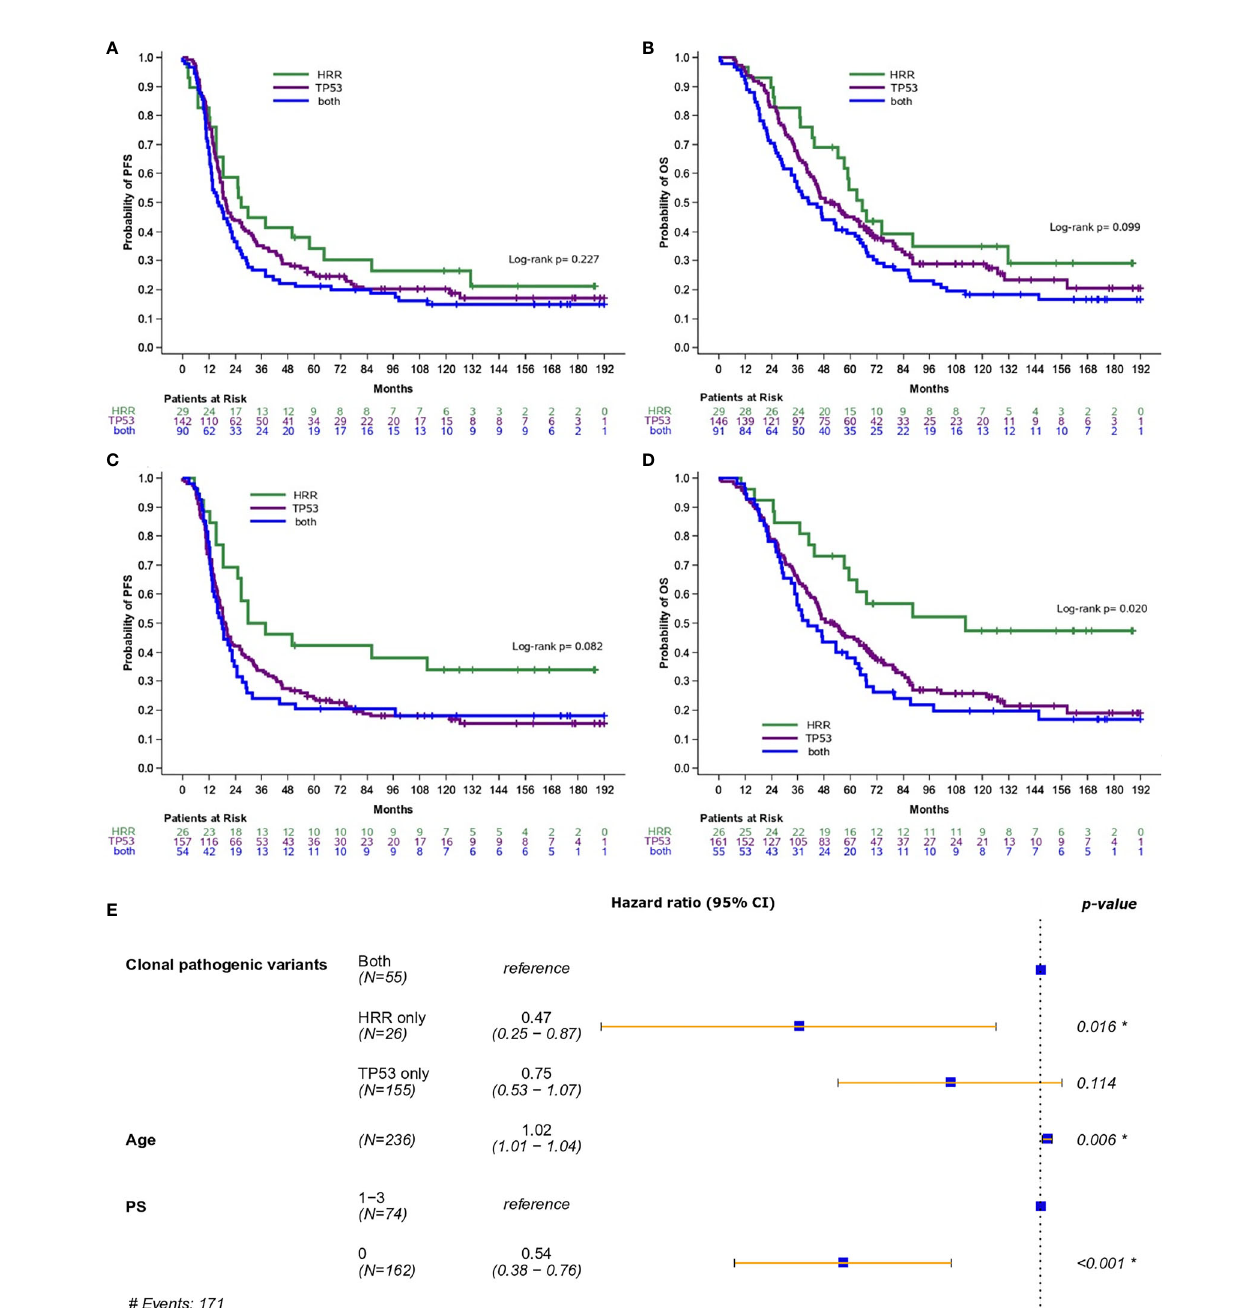
FIGURE 3 | Analysis was performed in patients with high-grade serous ovarian cancer. (A) Progression-free survival (PFS) and (B) Overall survival (OS) based on the presence of pathogenic variants in HRR and/or TP53 genes. (C) PFS and (D) OS based on the presence of clonal pathogenic variants in HRR and/or TP53 genes. (E) Forest plot of hazard ratios showing the risk of death for patients with HRR and/or TP53 clonal pathogenic variants upon adjustment for clinicopathological parameters. *Statistically signi fi cant